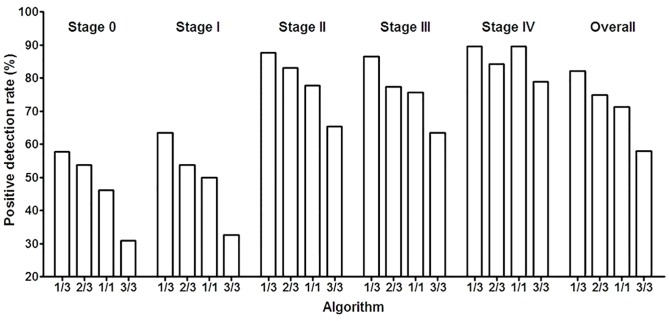
Early-stage CRC can be detected by the SEPT9 assay.The positivity detection rate was shown for each colorectal cancer stage in the opportunistic screening using various algorithm. Data was shown from stage 0 to stage IV and the overall PDR with 1/3, 2/3, 1/1 and 3/3 algorithm.